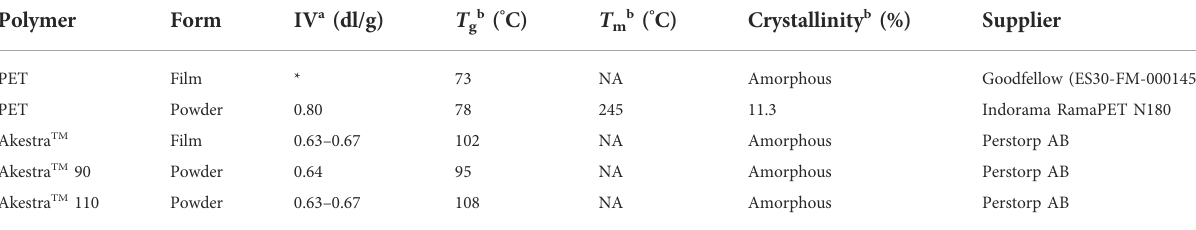
TABLE 1 Properties of the fi lms according to provider speci fi cations, and properties of the powder before dissolution-precipitation (crystallinity was determined after dissolution-precipitation).